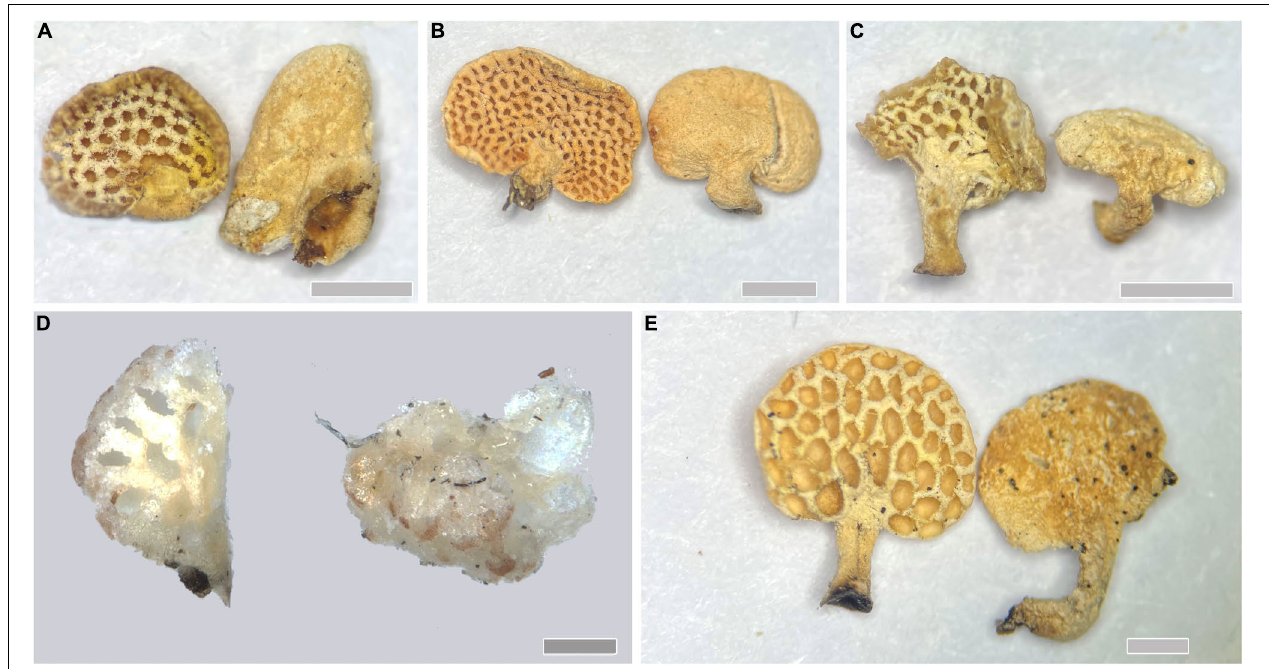
FIGURE 3 | Basidiocarps of Panellus species. (A) P. alpinus ; (B) P. crassiporus ; (C) P. longistipitatus ; (D) P. minutissimus ; (E) P. palmicola [Scale bars: (A–C,E) = 1 mm; (D) = 0.2